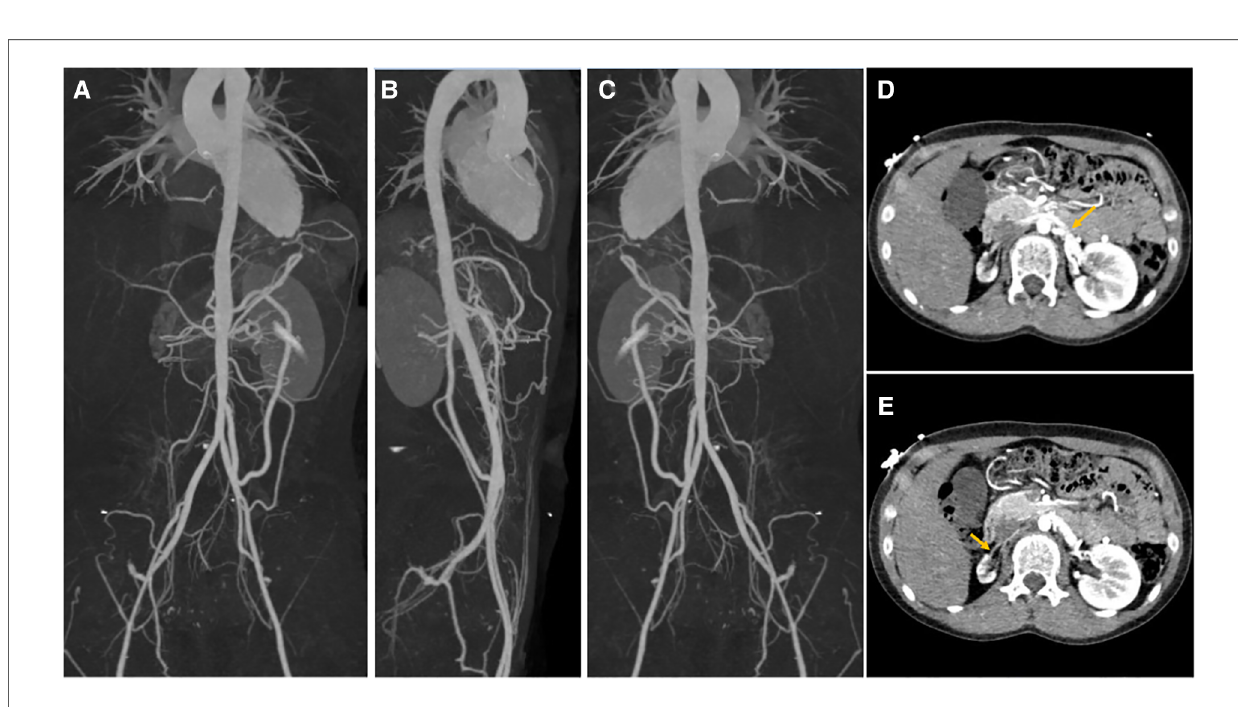
FIGURE 3 Stenosis of major and renal arteries in systematic CTA. The whole course of aorta was slender with multiple vascular thickening and stenoses. The diameter of the ascending aorta and was thoracic aorta about 21 and 12 mm, respectively. The wall of the aortic trunk and segments were thickened with calci fi cation. Slim right renal artery was present with a diameter of about 1 mm and thickened renal arterial intima. ( A ) Anterior view, ( B ) lateral view, ( C ) posterior view of systematic CTA, ( D ) stenotic lesions of the left renal artery ostia, and ( E ) stenotic lesions of the right renal artery ostia. CTA, computed tomography